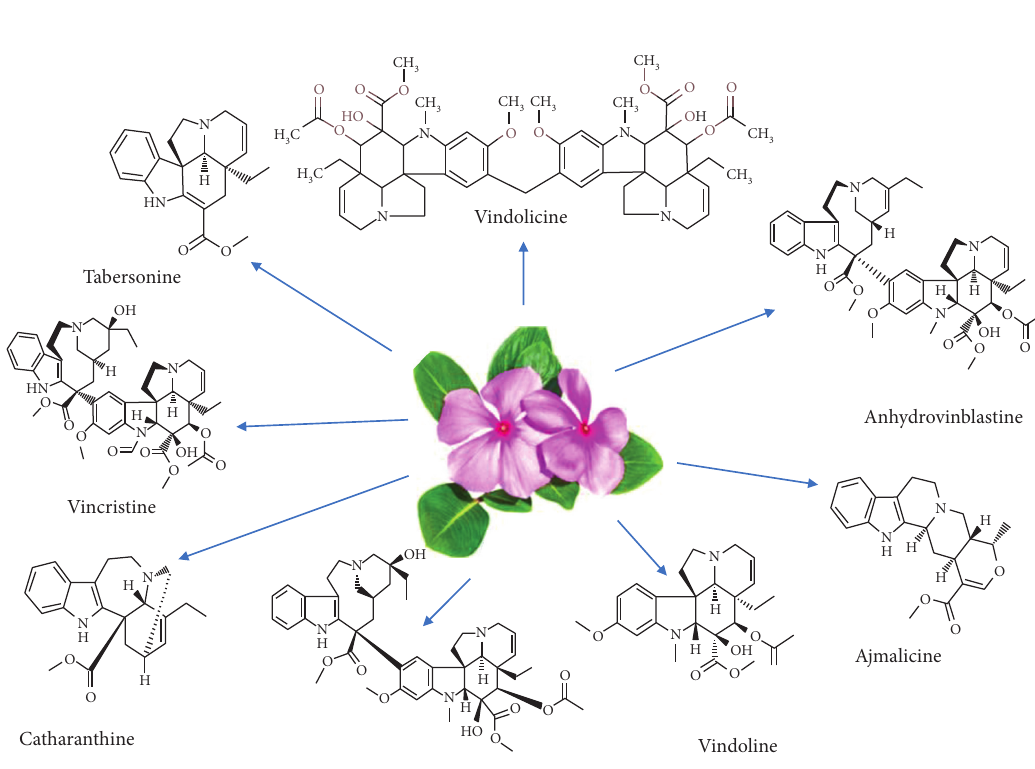
Figure 4: Antioxidants produced by Catharanthus roseus